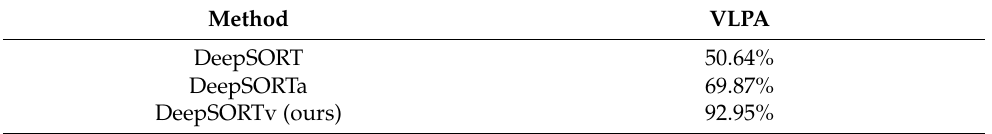
Table 6. The VLPA of different tracking modules.